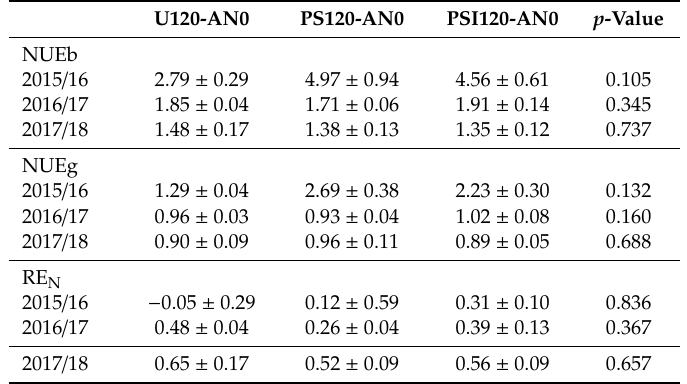
Table 4. Nitrogen use e ffi ciency indexes (NUEb, NUEg, and RE N ; mean ± standard error; n = 4) for the fertilized treatments U120-AN0, PS120-AN0, and PSI120-AN0 in the three cropping seasons.